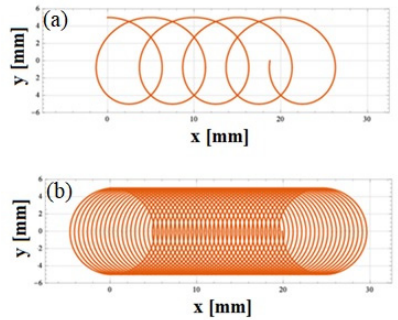
Figure 3. Example of circle electron-beam scanning figure at ( a ) low scanning frequency and ( b ) high scanning frequency [18]. (Reproduced with permission from ref. [18]. Copyright (2019), Elsevier).